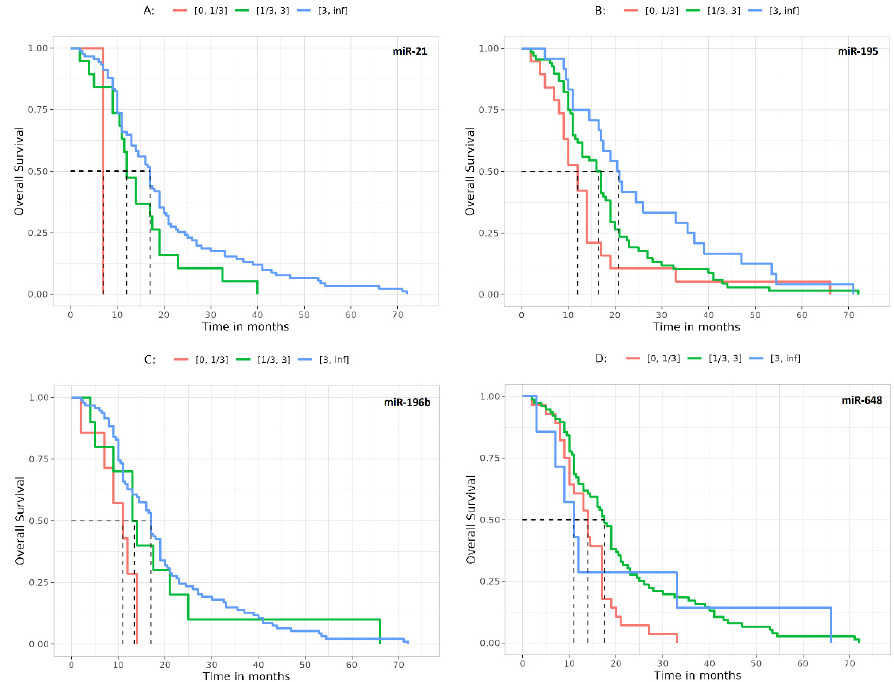
Figure 3. OS survival curves representing the survival of patients (in terms of months) on the basis of different miRNA expression. Only the curves of the miRNAs associated to a significant result are reported. ( A ) OS evaluated on miR-21. Dashed vertical lines: median survival times (months) [0, 1/3]: 7, [1/3, 3]: 12, [3, inf]: 17. ( B ) OS evaluated on miR-195. Dashed vertical lines: median survival times (months) [0, 1/3]: 12, [1/3, 3]: 16.5, [3, inf]: 20.8. ( C ) OS evaluated on miR-196b expression. Dashed vertical lines: median survival times (months) [0, 1/3]: 11, [1/3, 3]: 13.5, [3, inf]: 17. ( D ) OS evaluated on miR-648. Dashed vertical lines: median survival times (months) [0, 1/3]: 14, [1/3, 3]: 17.5, [3, inf]: 11. Abbreviations: OS, overall survival.